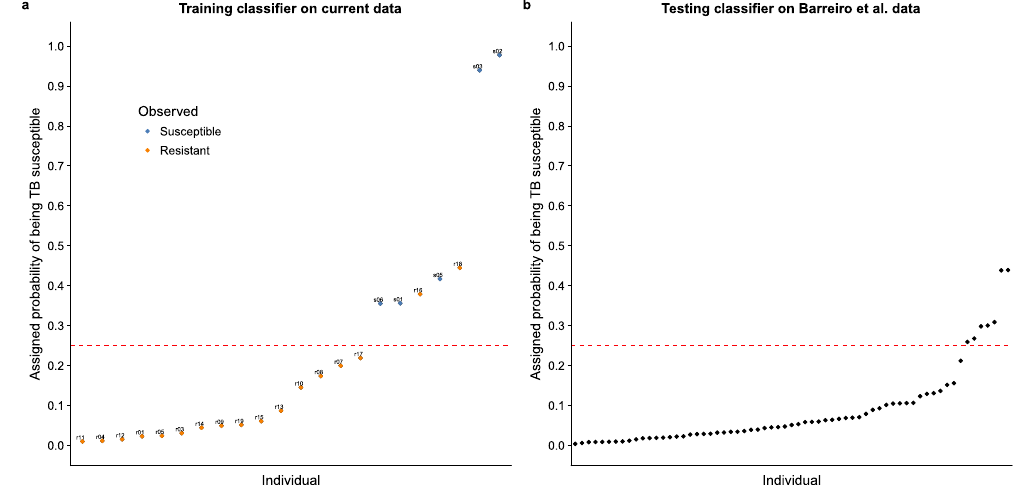
Figure 3. Classifying TB susceptible individuals using a support vector machine model. ( a ) The estimates of predicted probability of TB susceptibility from the leave-one-out-cross-validation for individuals in the current study. The blue circles represent individuals known to be susceptible to TB, and orange those resistant to TB. The horizontal dashed red line at a probability of 0.25 separates susceptible and resistant individuals. ( b ) The estimates of predicted probability of TB susceptibility from applying the classifier trained on the data from the current study to a test set of independently collected healthy individuals 24